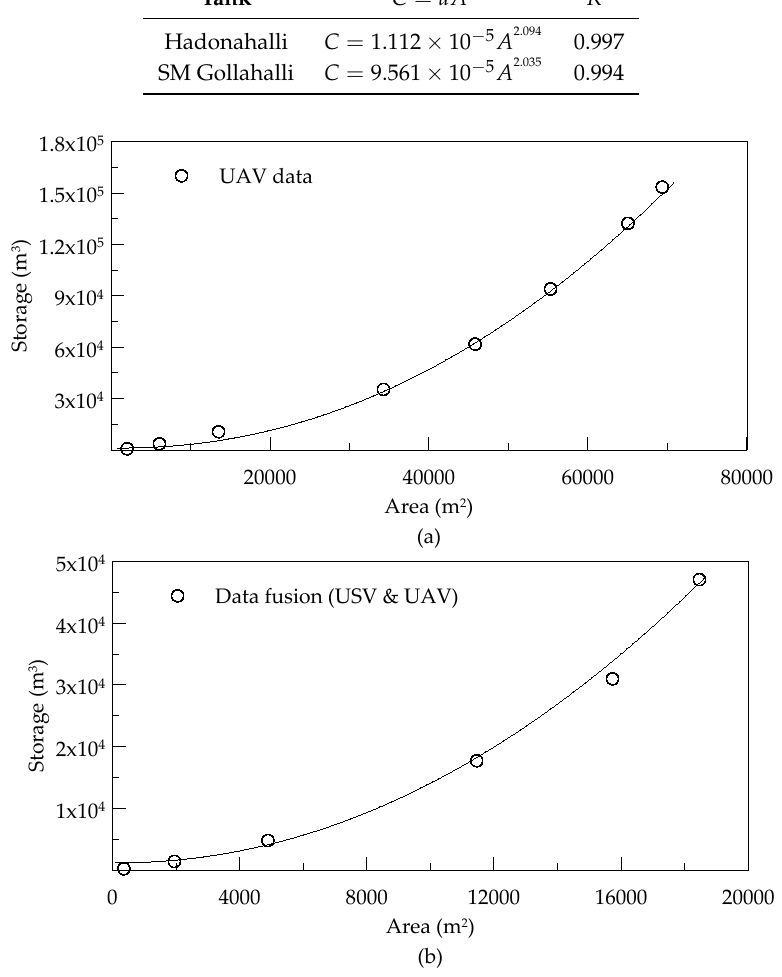
Figure 8. Area-storage relationships for ( a ) Hadonahalli tank and ( b ) data-fusion data from SM Gollahalli tank. Area-storage data are plotted against the C = aA b curve fit presented in Table